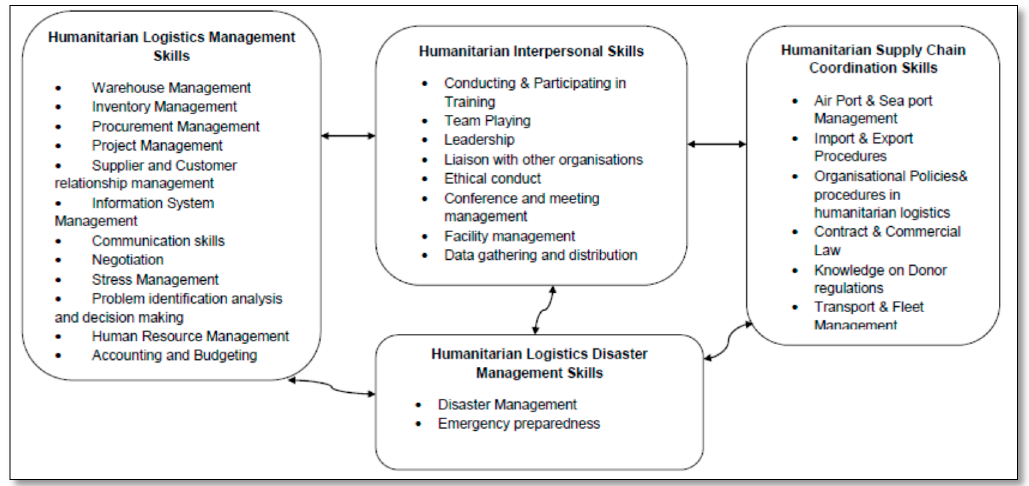
Figure 1. Skills and competencies profile for Sri Lankan HL practitioners [21].